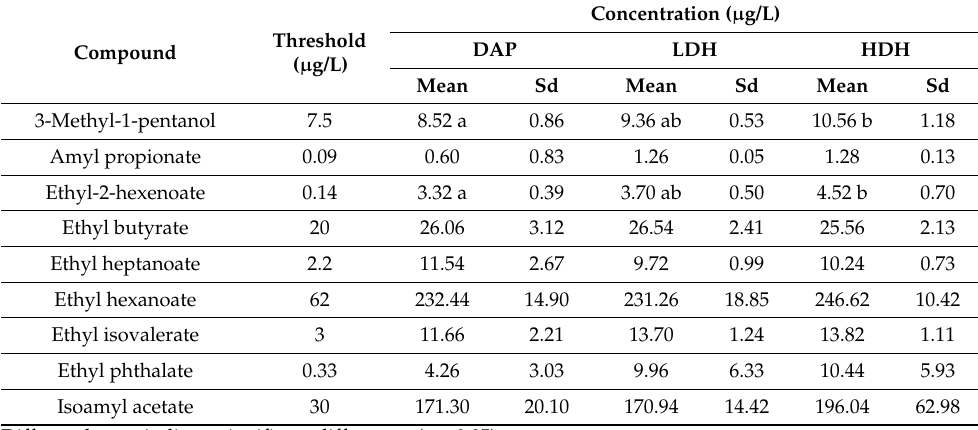
Table 2. List of volatile compounds with significant OAV for the different nitrogen